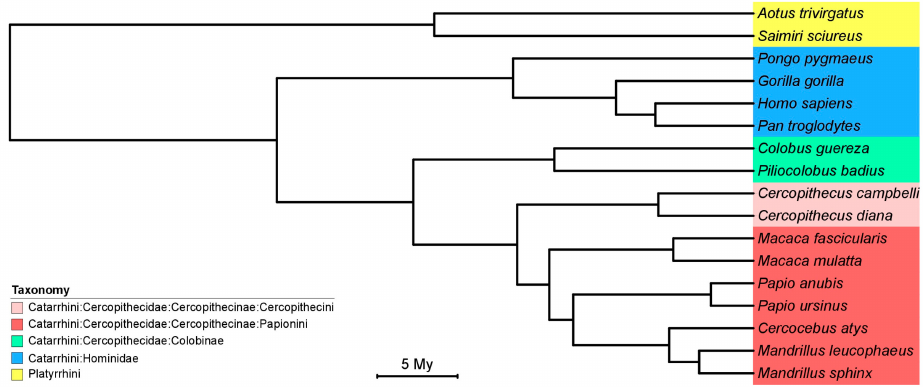
Figure 2. Time tree of nonhuman primate host species. This time tree was produced using a precompiled set of posterior trees available at the 10KTrees webserver [36]. Host common names are as follow: Aotus trivirgatus (three-striped night monkey), Cercocebus atys (sooty mangabey), Cercopithecus campbelli (Campbell’s monkey), Cercopithecus diana (Diana monkey), Colobus guereza (guereza), Colobus polykomos (black-and-white colobus), Gorilla gorilla (Western lowland gorilla), Macaca fascicularis (cynomolgus monkey), Macaca mulatta (rhesus macaque), Mandrillus sphinx (mandrill), Mandrillus leucophaeus (drill), Pan troglodytes (chimpanzee) , Papio anubis (olive baboon), Papio ursinus (chacma baboon), Piliolobus badius (western red colobus), Pongo pygmaeus (Borneo orangutan), Saimiri sciureus (common squirrel monkey).